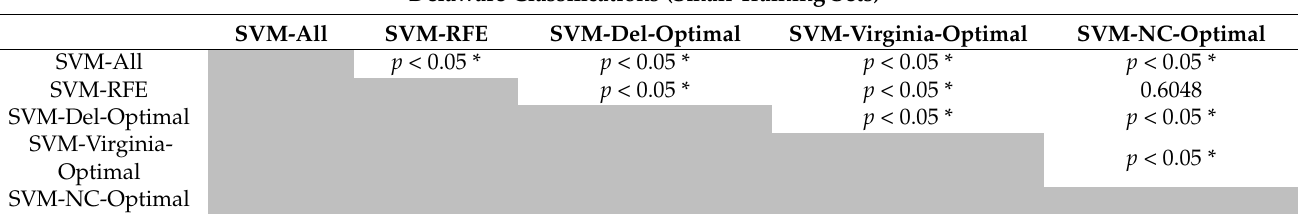
Table A1. Paired t -test p -values for Delaware classifications trained from the small training sets. (* In- dicates at a 95% confidence that the differences in mean classification accuracies between classification groups are statistically significant, p < 0.05).